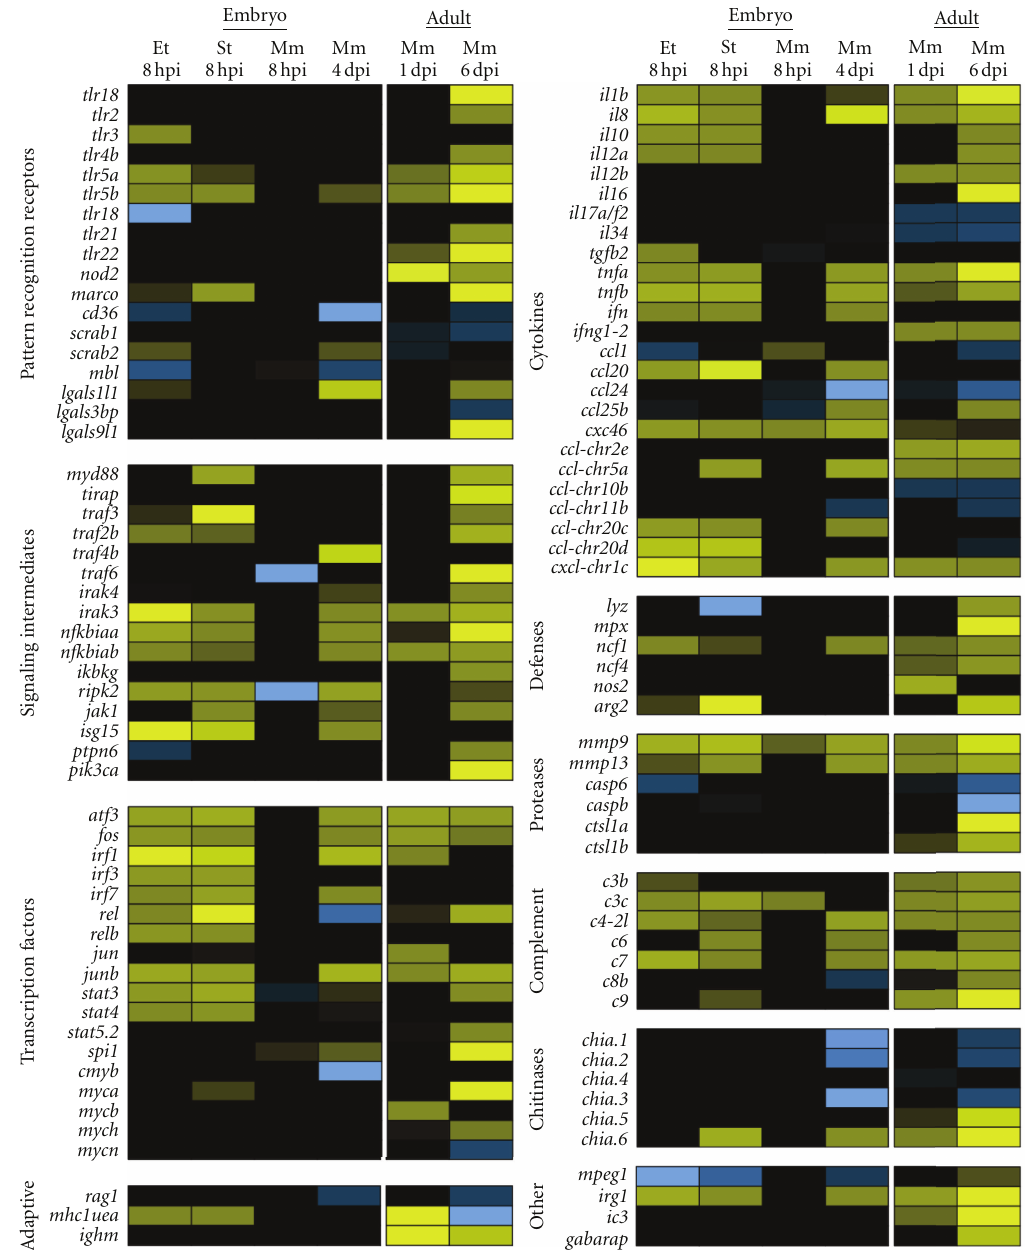
Figure 4: Comparison of the zebrafish innate immune response to di ff erent bacterial pathogens. Gene expression profiles of zebrafish embryos and adults infected with E . tarda FL6-60 (Et), S . typhimuriumSL 1027(St) , and M . marinum Mma20 (Mm) are depicted in a heat map. Embryos were infected with 200 CFU of each pathogen into the caudal vein at 28 hpf and snap frozen individually at 8hpi for E. tarda and S . typhimurium , and at 8hpi and 4dpi for M . marinum . Triplicate samples for each infection condition were compared with samples from control embryos (injected with PBS) using a common reference microarray design. The raw data were deposited in the Gene Expression Omnibus database under accession number GSE35474. The data derived from embryonic infections were compared with data from a study in which adult zebrafish were infected intraperitoneally with M . marinum Mma20, after which RNA samples were taken at 1 dpi and 6 dpi [22]. The dose of the Mma20 strain used in the adult infection study was lethal within days after the final sampling point at 6dpi. Only genes relevant to this paper were included in the heatmap. All selected genes are represented by a minimum of two probes that showed significant up or downregulation (significance cut-o ff s for the ratios of infected versus control groups were set at 2-fold with P < 10 − 5 ). Upregulation is indicated by increasingly bright shades of yellow, and downregulation is indicated by increasingly bright shades of blue. It should be noted that the genes listed in this figure are named according to sequence homology with mammalian counterparts and in most cases have not yet been confirmed